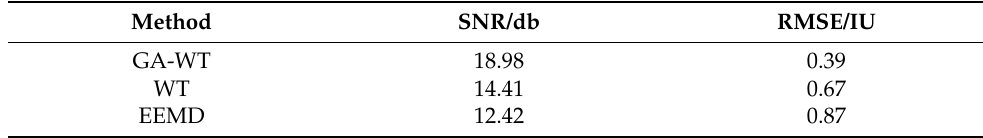
Table 1. Comparison of the three